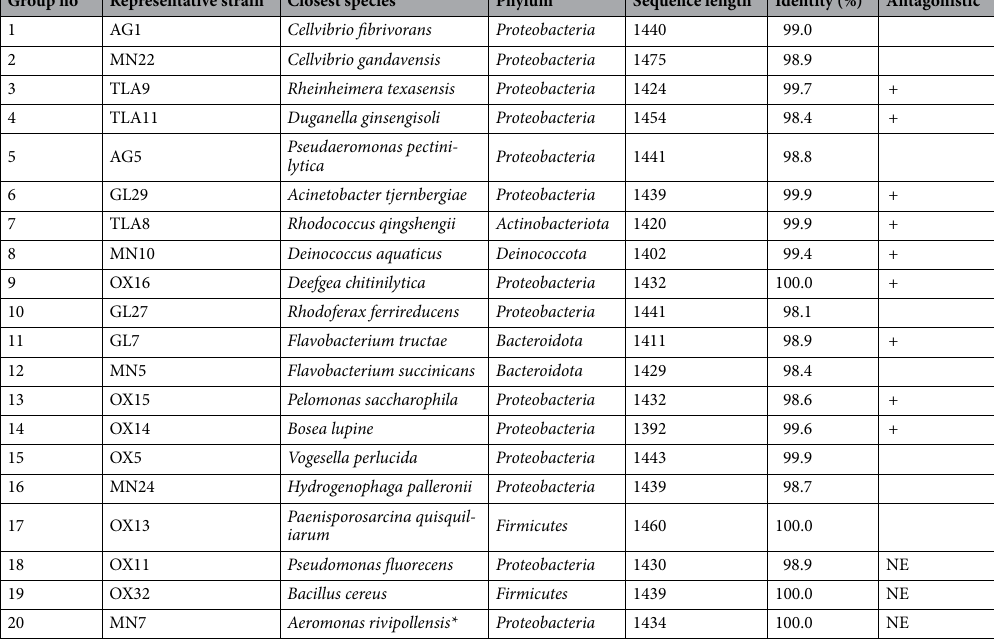
Table 1. Representative strains and closest species. Identity (%), 16S rRNA gene similarity with closest species; NE, not evaluated; Sequence length, length of 16S rRNA gene. NE, not evaluated; Sequence length, length of 16S rRNA gene. + , postitive antagonistic action against at least one strain of F. psychrophilum. * Strain MN7 was also close to Aeromonas caviae at sequence identity of 99.9%.